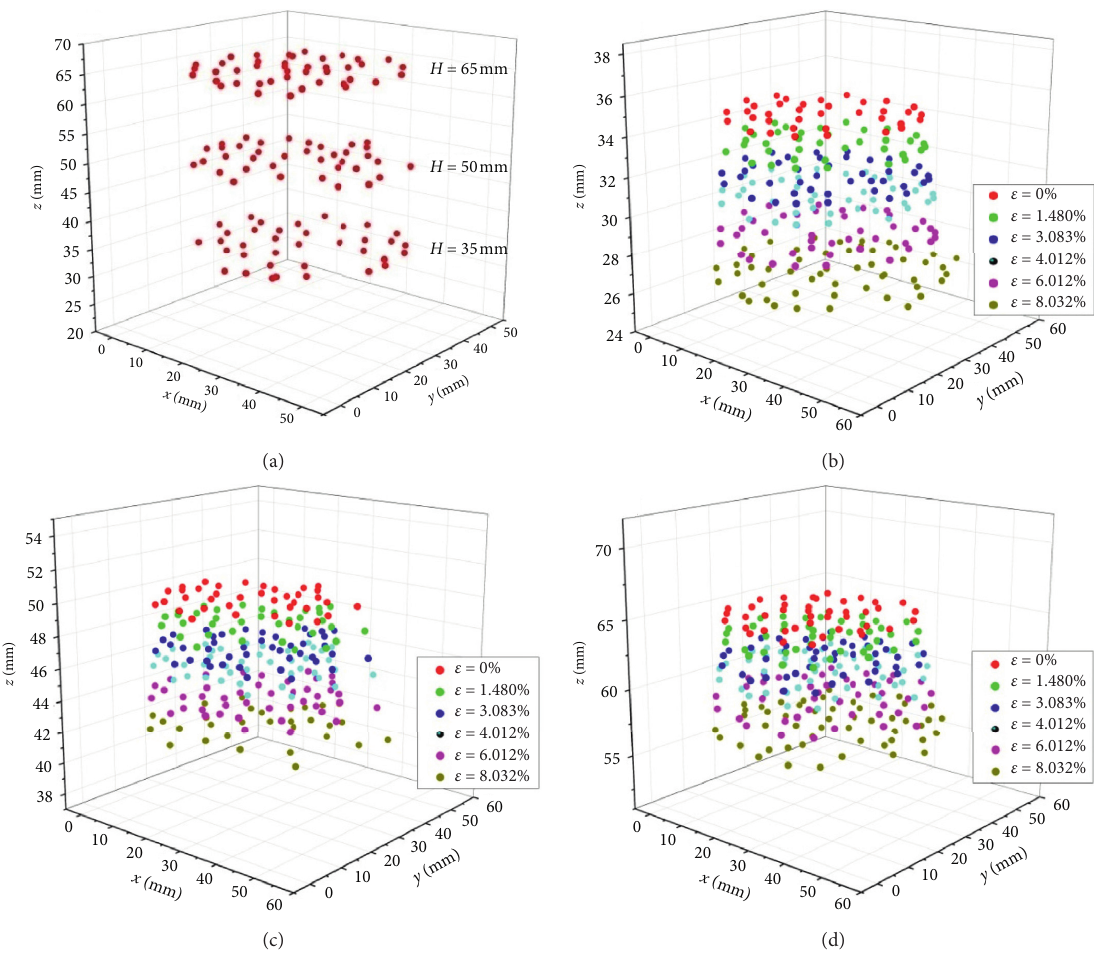
Figure 6: Spatial positions of rock blocks during deformation, for the three x-ray CT scanned